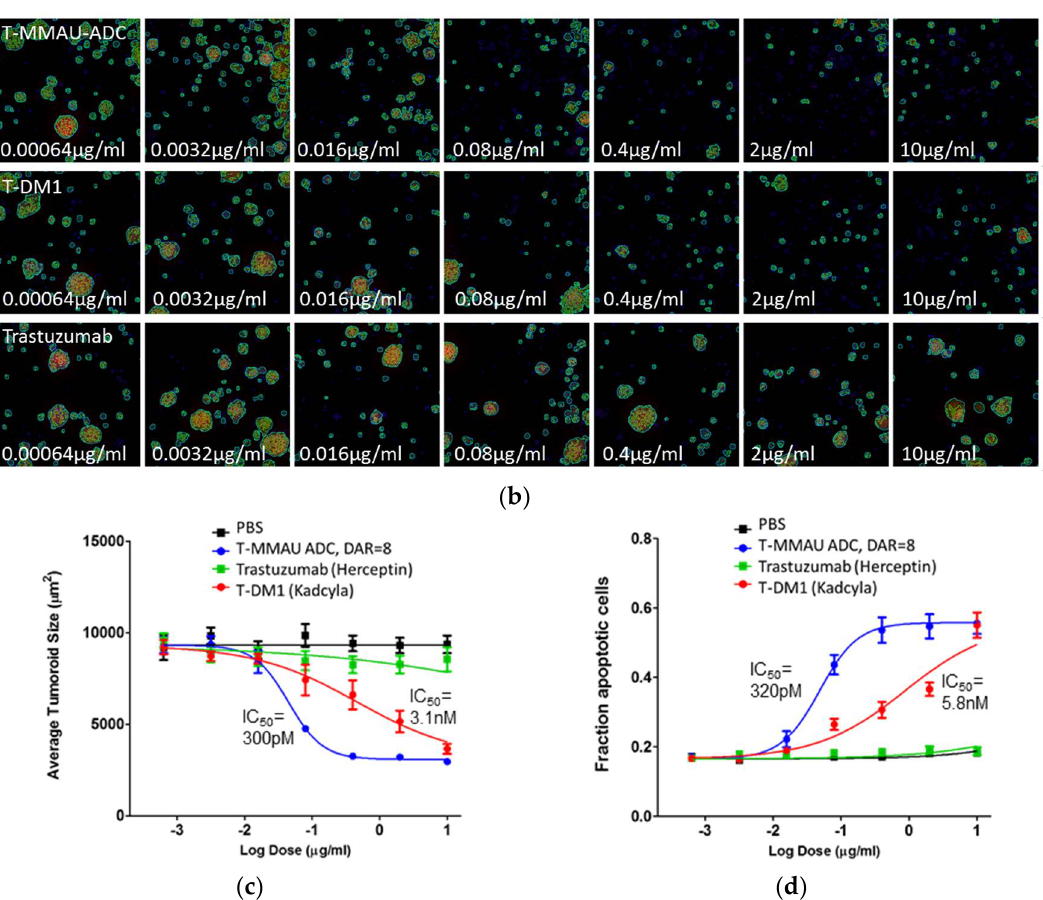
Figure 5. In vitro 3D patient-derived xenograft (PDX) model. ( a ) GXA3067 is a HER2 overexpressing gastric tumor PDX model; ( b ) Size-filtered tumoroids were seeded in 384-well plates and treated with increasing concentrations of ADCs, the trastuzumab-based DAR = 8 MMAU ADC (T-MMAU ADC, upper row) and T-DM1 (Kadcyla ® , middle row); as well as the naked antibody trastuzumab (bottom row). ( c ) The DAR = 8 MMAU ADC was 10× more effective in reducing tumoroid size than T-DM1, while trastuzumab had only a moderate effect. ( d ) The DAR = 8 MMAU ADC was 18× more effective in inducing apoptosis than T-DM1, while trastuzumab did not have an effect. IC 50 values are marked in the figure panels and they were determined using curve fitting by nonlinear regression as the concentration of the drug that causes 50% inhibition of cell viability compared to maximum inhibition. The experiments were made with eight replicates. Error bars show the standard error of the mean.